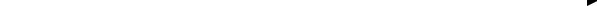
Fig. 9. ESRAD observations of horizontal wind vectors for 10 January 1997 ( a ), for 24 January 1997 ( b ) and for 26 January 1997 ( c )